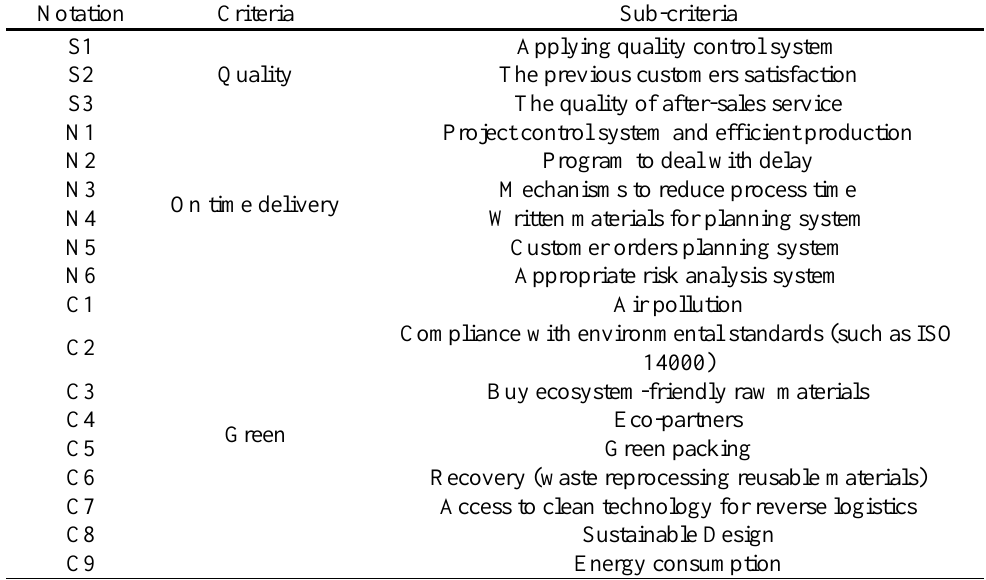
Table 6. The criteria and sub-criteria of evaluating the